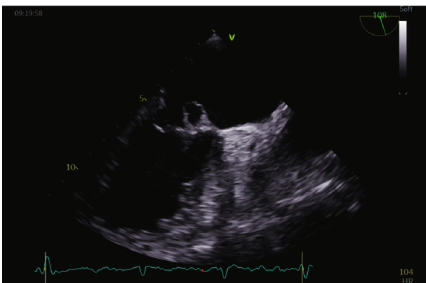
Figure 1: Echocardiogram shows anterior mitral valve lea fl et aneurysm.